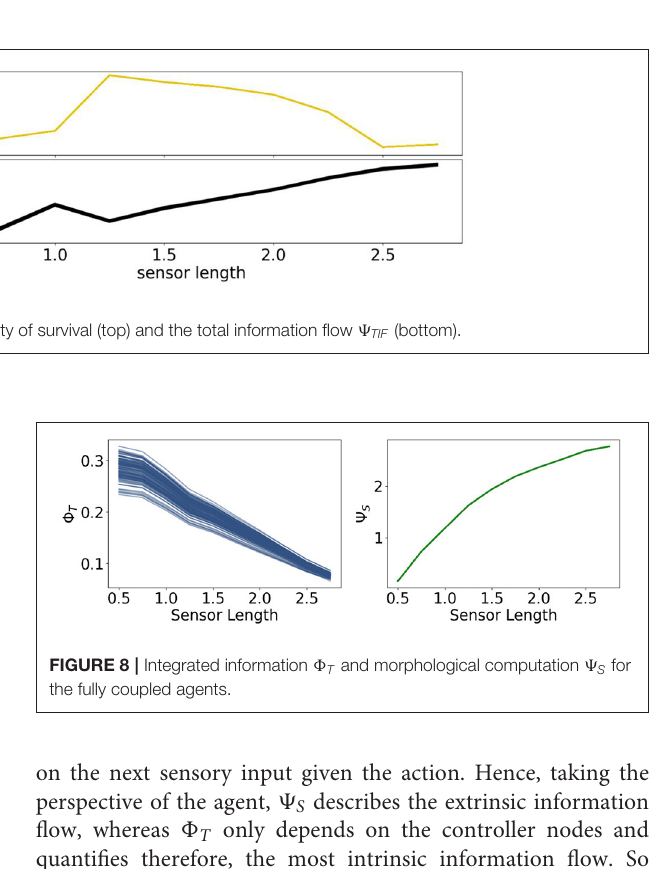
FIGURE 6 | Calculation of the measures for (c) reactive control, (d) action effect, (e) sensory information, (f) control and (g) total information flow.